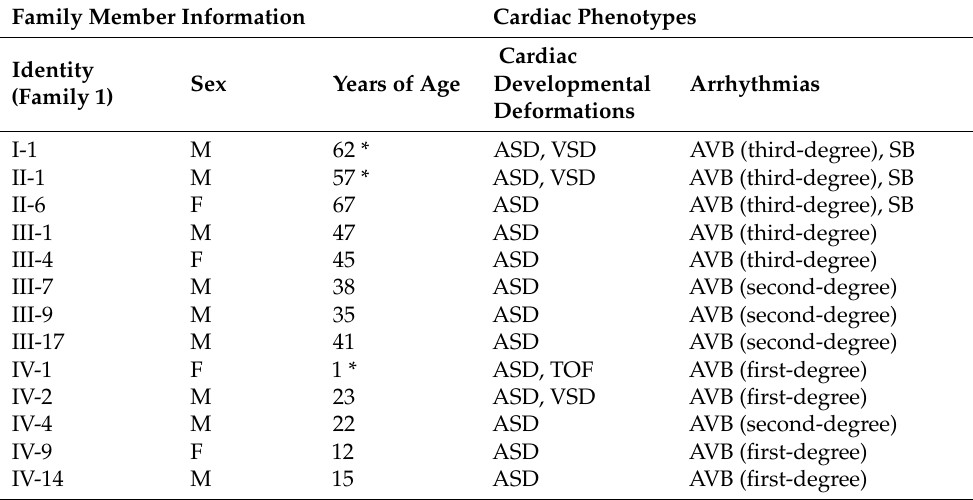
Table 1. Basic clinical information of the affected individuals from Family 1 suffering congenital heart disease and cardiac arrhythmias.